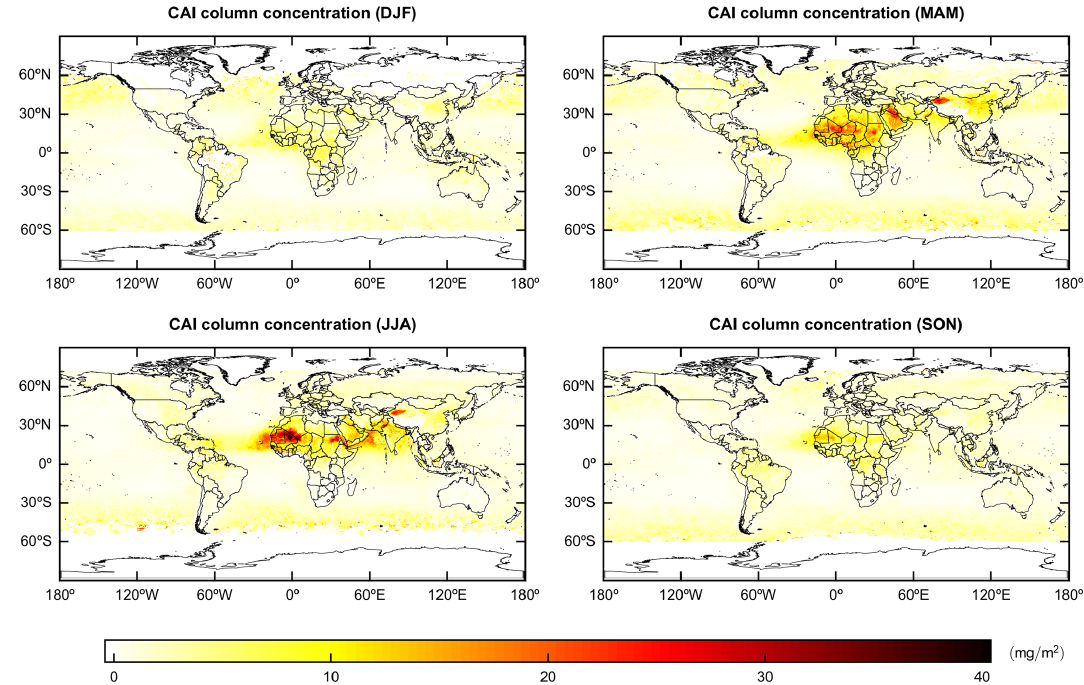
Figure 8. Spatial distribution of seasonal coarse-mode absorbing insoluble (CAI) column mass concentration (mgm − 2 ) derived from POLDER-3 observations using the GRASP/Component approach. December–January–February (DJF); March–April–May (MAM); June–